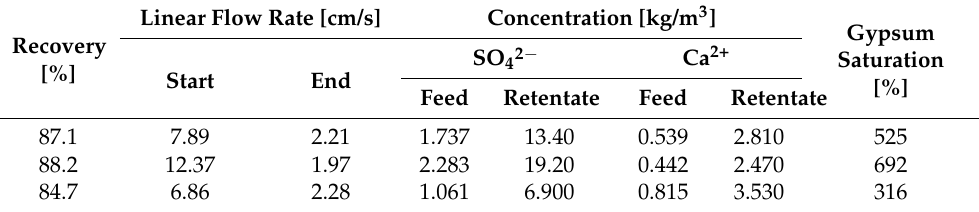
Table 2. Concentration of Ca 2+ , SO 42 − in the feed water and the NF retentate, corresponding gypsum saturation, the NF permeate recovery and the linear flow rate in the feed/retentate channel at the beginning of 1st-stage/end of 3rd-stage during experiments with Na 2 SO 4 /CaCl 2